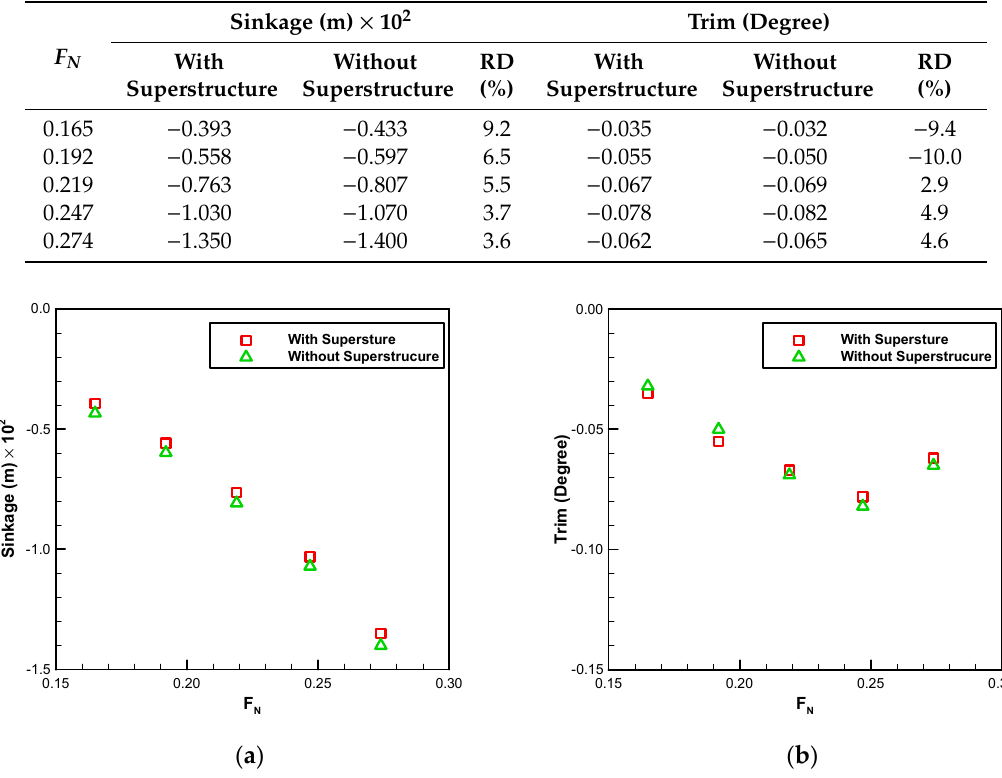
Figure 6. Comparison of simulation results with and without superstructures (a positive trim value was defined bow up and positive sinkage value was defined upwards). ( a ) Sinkage and ( b ) trim.